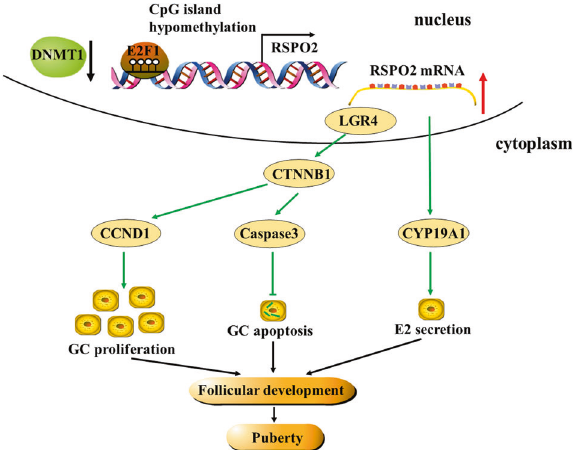
Fig. 8 The mechanistic scheme of DNA-methylation-mediated RSPO2 regulating GCs proliferation, apoptosis and E2 secretion. The hypomethylation of CGI2 in RSPO2 promoter facilitated the occupancy of E2F1 and enhanced the transcription of RSPO2, which further promoted the proliferation and E2 secretion of GCs, inhibited the apoptosis of GCs and ultimately ameliorated the development of follicles and pubertal initiation through Wnt signaling